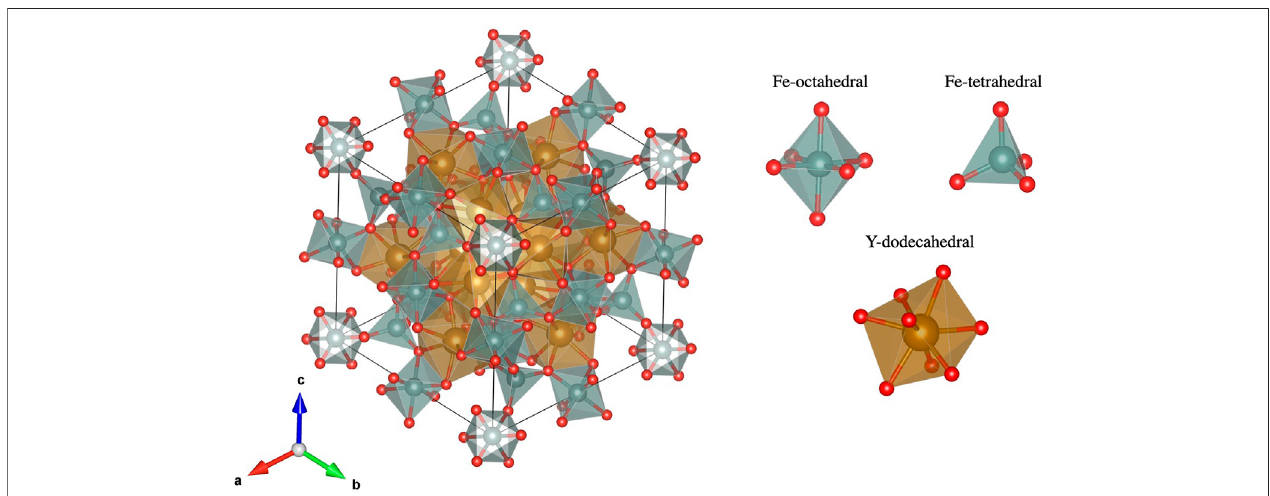
FIGURE6| Unit cellofagarnet. Oxygen atoms are shown inred,whileiron atomsareshown inside thegrey polyhedra. Therare-earth or yttrium atomsareshown inside the golden dodecahedra. While the yttrium or rare-earth atoms are all symmetry equivalent the iron is present in two different environments. Structure from (Y3Fe5O12 crystal structure, 2012) and plotted with (Momma and Izumi,